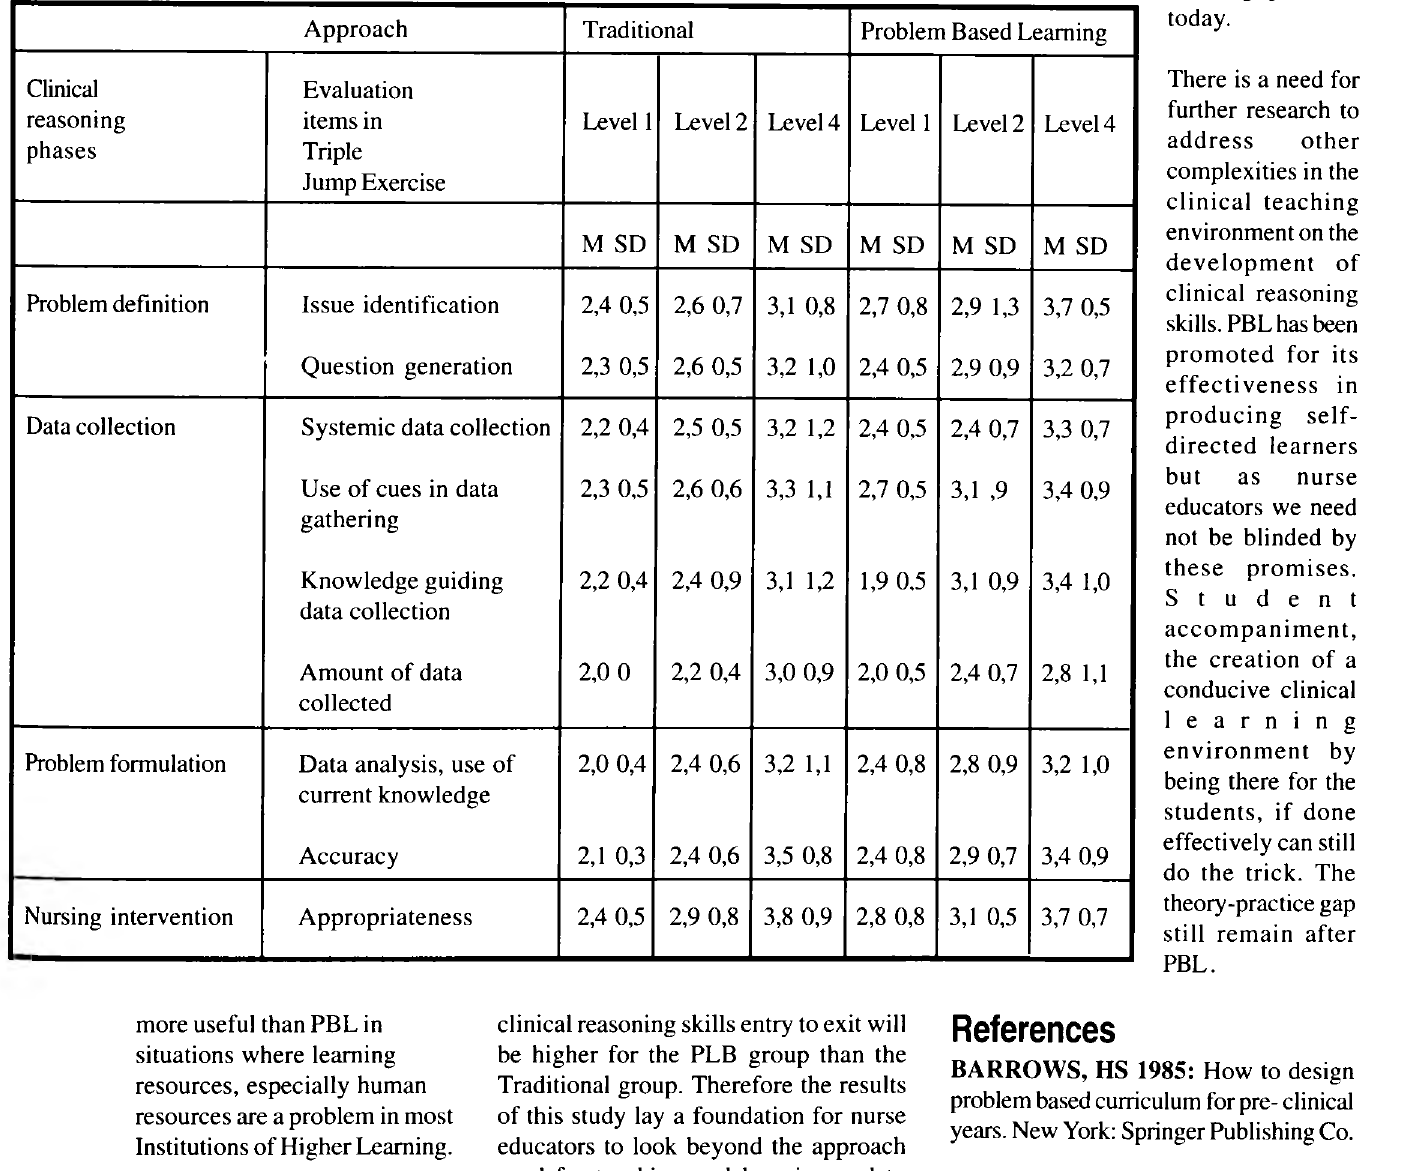
Table 4: Performances in each evaluation item by all levels of the study